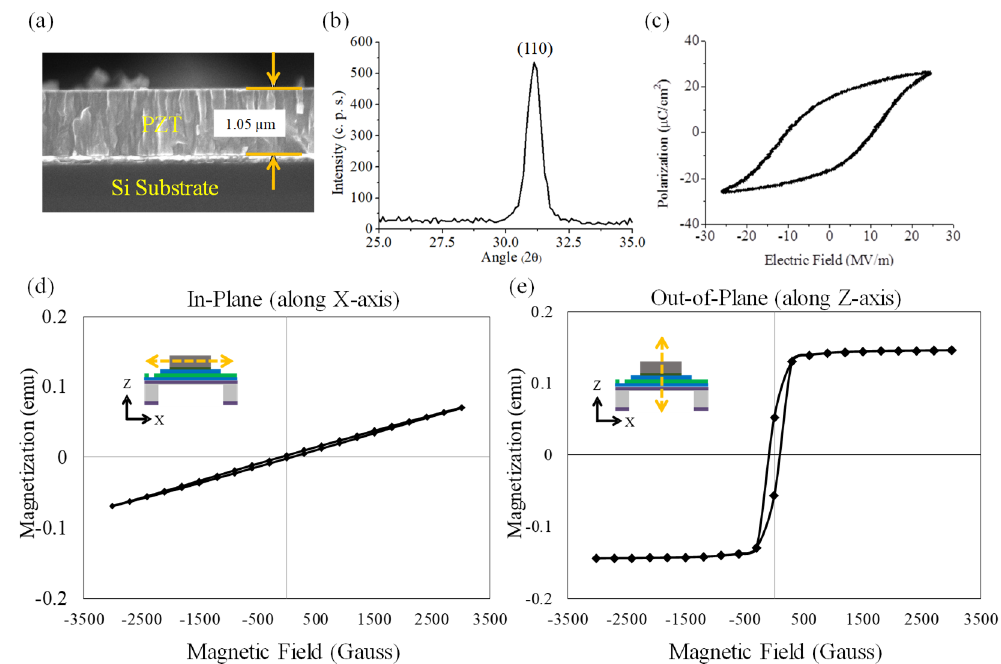
Figure 5. The characterization results of the fabricated Ni-thick-film / PZT-thin-film bi-layered structure: ( a ) the scanning electron microscopy (SEM) image of the PZT thin film, ( b ) the X-ray diffraction pattern of the PZT thin film, ( c ) the ferroelectric hysteresis loop of the PZT thin film, ( d ) out-of-plane (X-axial), and ( e ) in-plane (Z-axial) ferromagnetic hysteresis loop of the Ni thick film.